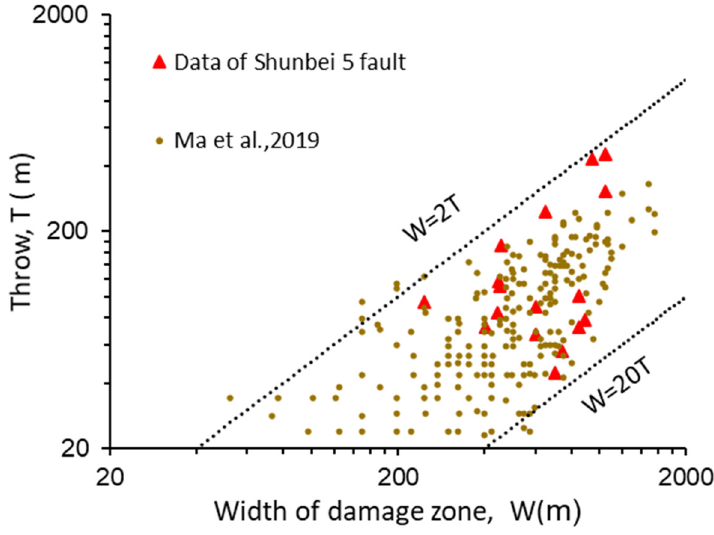
Figure 10. The plot of the damage zone width (W) versus the throw (T).